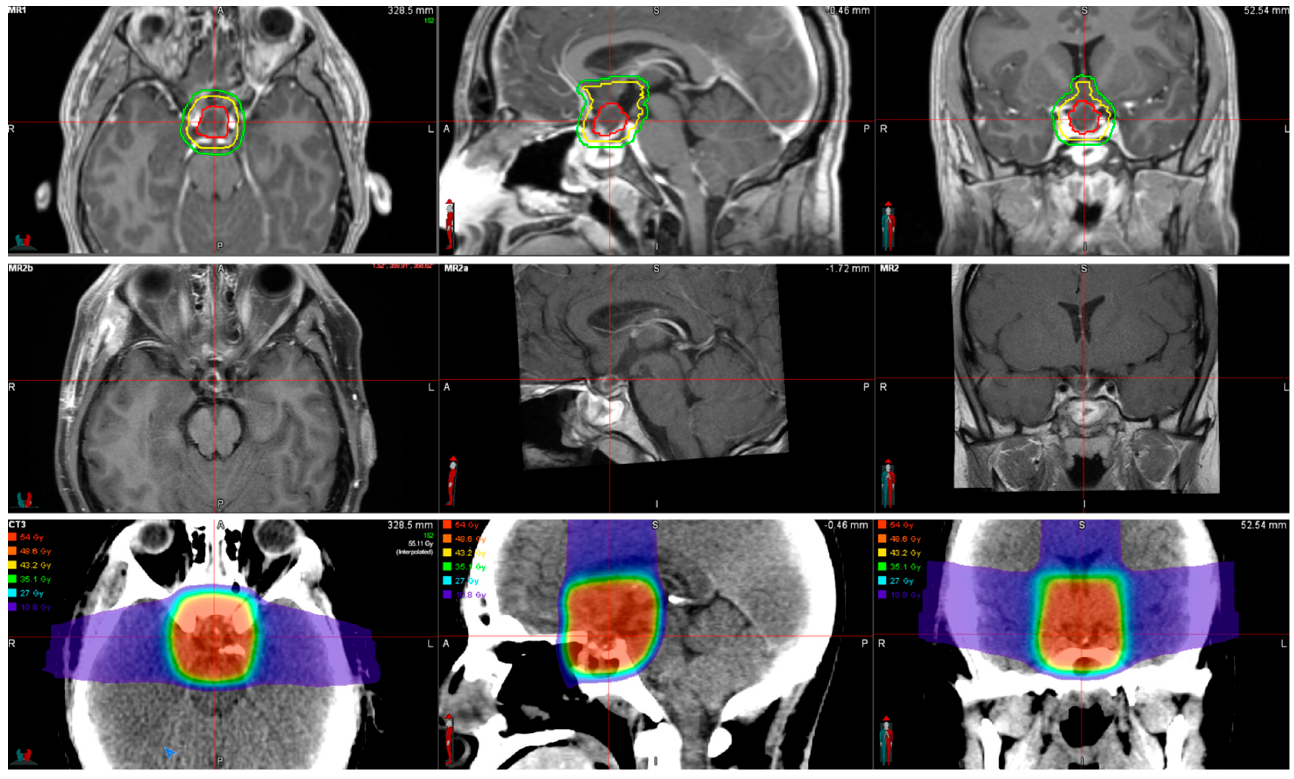
Figure 1. Twenty-nine year old patient with recurrent adamantinomatous craniopharyngioma treated with salvage surgery and post-operative proton radiotherapy. Row 1. Pre-op MRI shows suprasellar cystic tumor with enhancing wall involving the optic pathway. Pre- and post-operative tumor volumes inform the radiation target contours as overlayed on the images. GTV (red) = gross tumor volume (based on pre-op gross tumor), CTV (yellow) = clinical target volume (encompassing areas of tumor extent at initial presentation and areas at risk of subclinical disease), PTV (green) = planning target volume. Row 2. Post-op MRI shows residual cystic tumor involving the optic pathway. Row 3. Radiation planning CT with radiation dose overlay. Pencil beam scanning proton radiation was utilized to deliver a prescription dose of 54 GyRBE in 1.8 GyRBE fractions.